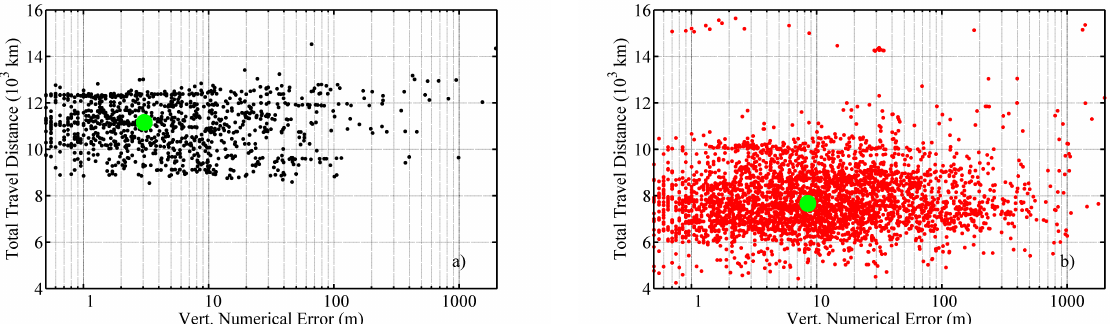
Fig. 2: Relationships between total travel distances accumulated over 12 days and corresponding numerical errors in the vertical plane from F/B tests for (a) a selected set of back trajectories approaching South America and (b) a group of trajectories traversing the ITCZ. Median values are marked as green dots.